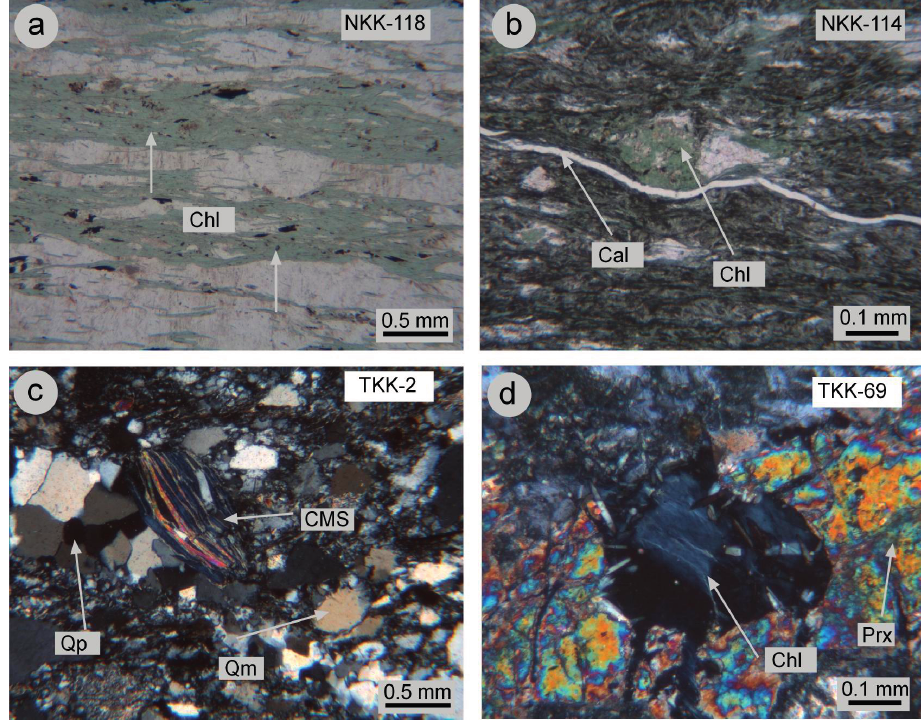
Figure 2. Optical microphotograps of chlorite and associated minerals in the Lower Karakaya Complex units (Chl = Chlorite, Qp = Polycrystalline quartz, Qm = Monocrystalline quartz, CMS = Chlorite-muscovite stack, Cal = Calcite, Prx = Pyroxene, ppl = plane polarized light, cn = crossed polars); ( a ) Typical metamorphic differentiation in the schists of the Nilüfer Unit (ppl); ( b ) Isotropic-view chlorite porphyblasts and pore filling